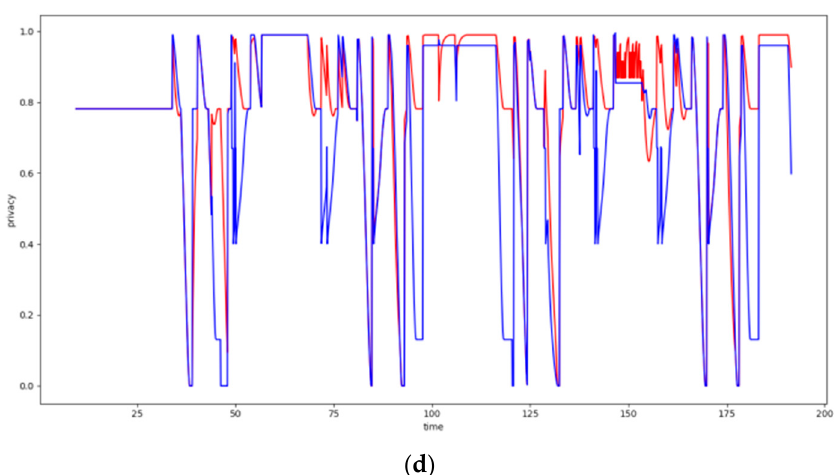
Figure 12. Evaluation results for dynamic clustering over the topology of 37 nodes for ( a ) 2 servers and square_1 trajectory, ( b ) 3 servers and square 1 trajectory, ( c ) 2 servers and h_line_2 trajectory, ( d ) 3 servers and h_line_2 trajectory. Table 1. Average privacy achieved by the walkthrough algorithm for the topology of 37 nodes.